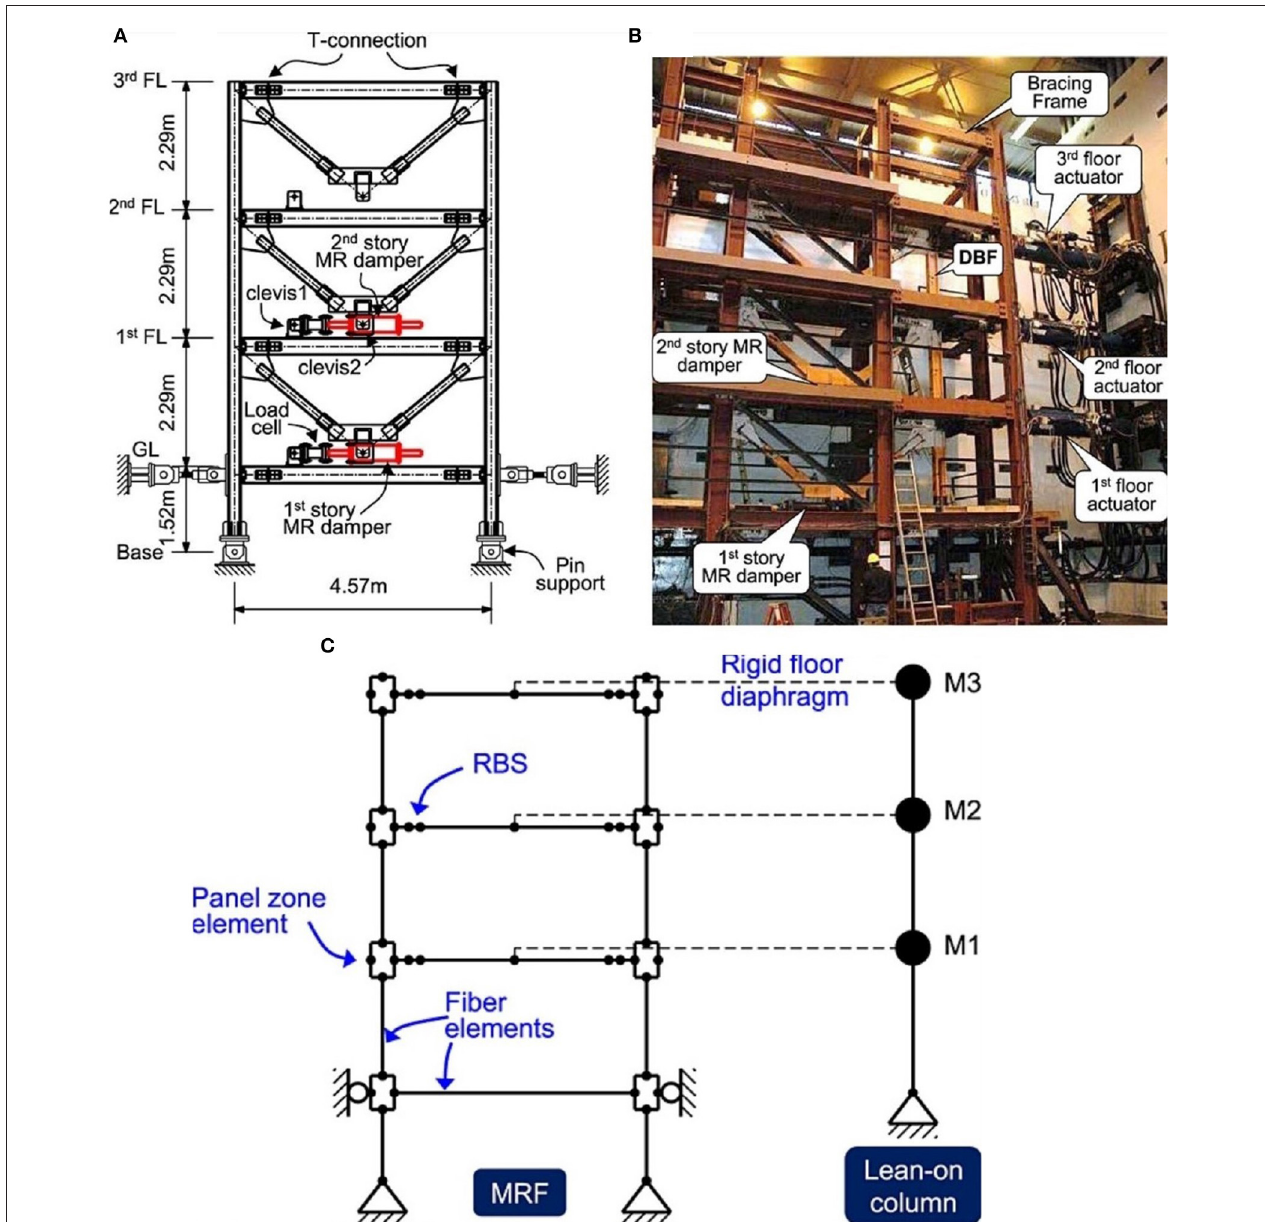
FIGURE 6 | RTHS of a three-story building with MR dampers: (A) schematic of the experimental substructure, (B) photograph of the experimental test setup, and (C) analytical substructure (reprinted from Chae et al., 2014 with permission).